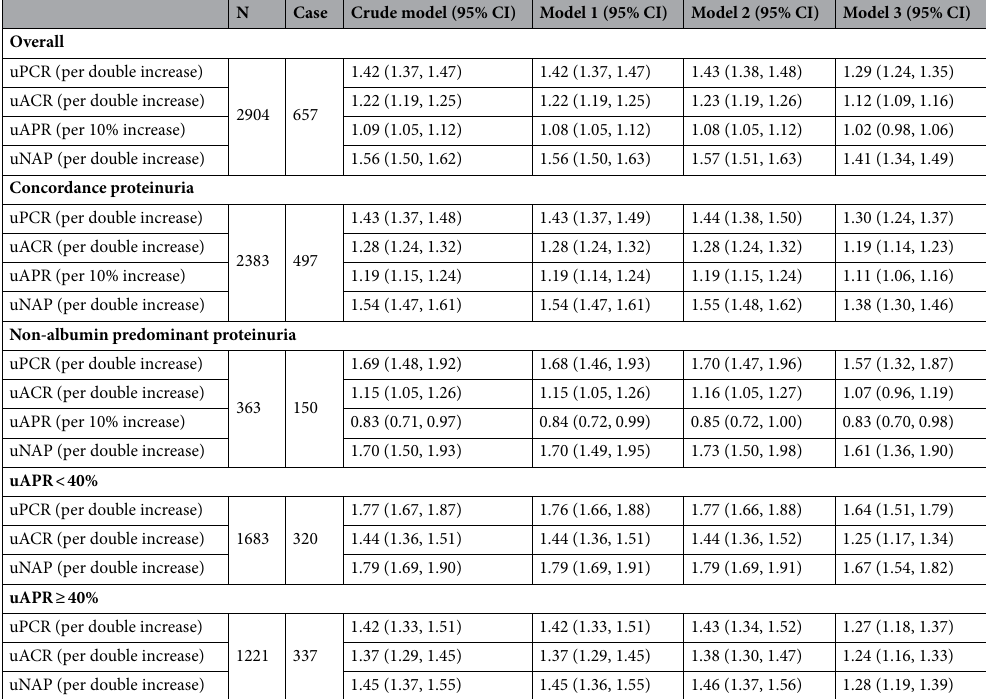
Table 4. Hazard ratios (95% confidence interval) of risk of all-cause mortality by uPCR, uACR, uAPR, and uNAP by the concordance between uPCR and uACR and uAPR above or below 40% (based on imputation dataset). Model 1: Adjusted gender, diabetes, hypertension, cardiovascular disease and cancer. Model 2: Adjusted gender, diabetes, hypertension, cardiovascular disease, cancer, ACEI, ARBs, and anti-platelet agents. Model 3: Adjusted gender, diabetes, hypertension, cardiovascular disease, cancer, ACEI, ARBs, anti-platelet agents, eGFR, hemoglobin, and glucose. ACEI angiotensin-converting-enzyme inhibitors, ARBs angiotensin receptor blockers, eGFR estimated glomerular filtration rate, uAPR urine albumin-to-protein